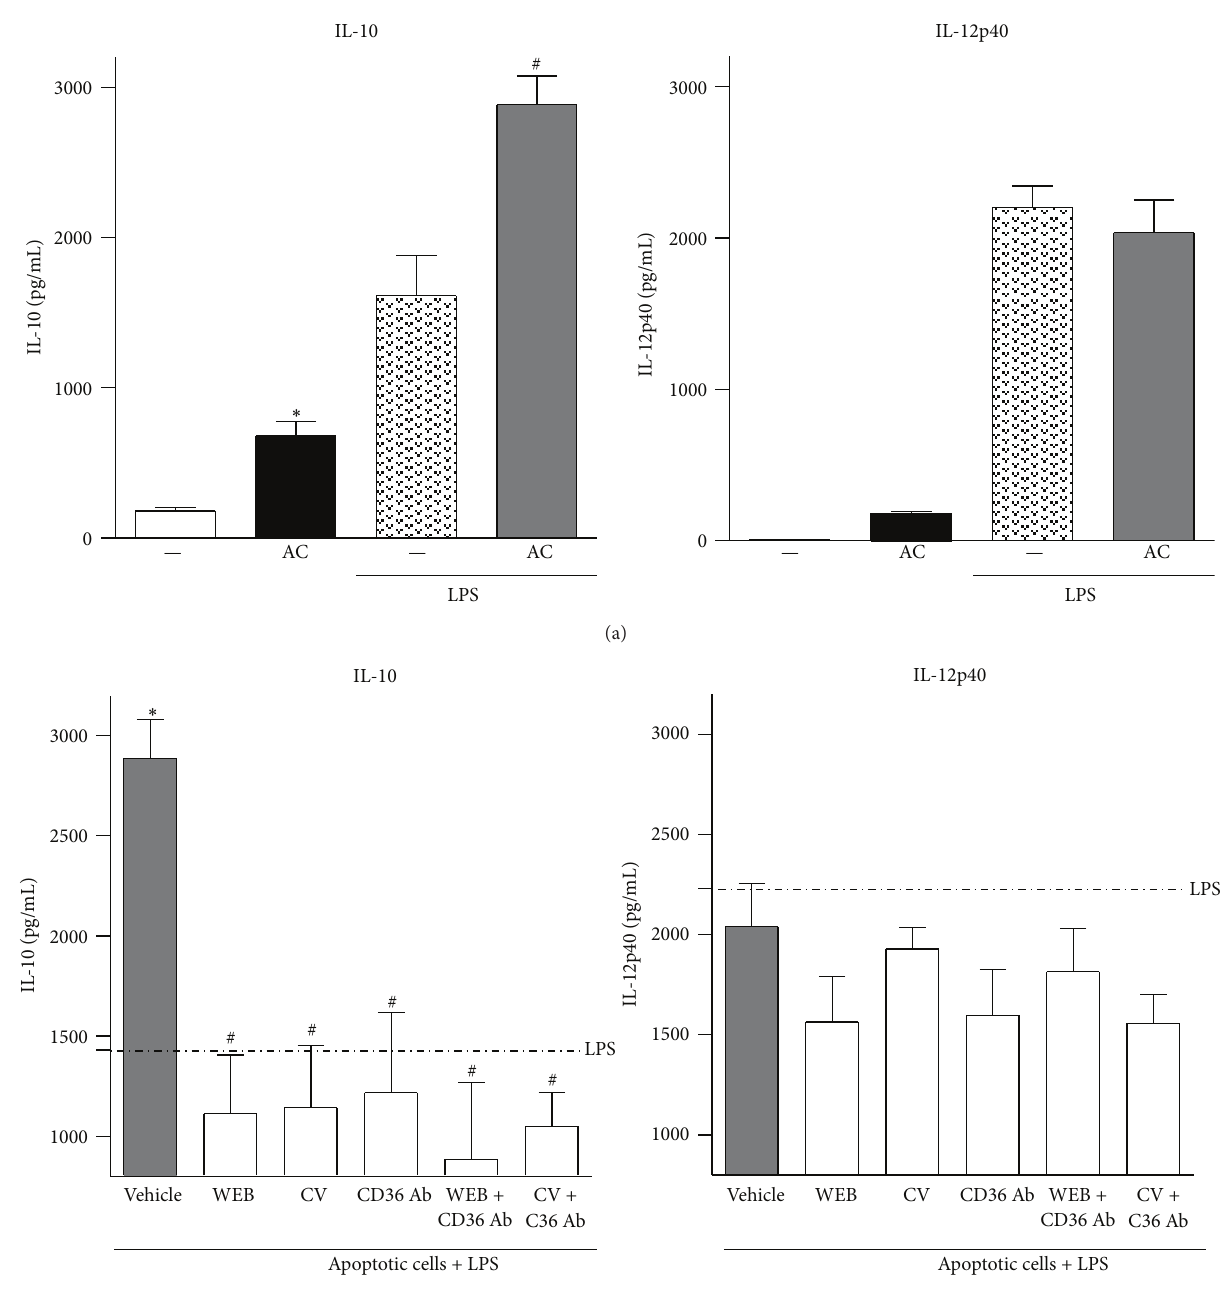
Figure 4: Efferocytosis-induced IL-10 and IL-12p40 production. Apoptotic thymocytes were added to BMDM (10 per macrophage), and after 24 h the supernatants were assayed (a). Another group, after 24h of contact with apoptotic cells, was stimulated with LPS (10ng/mL), and supernatants were assayed after 24. Treatments with PAFR antagonists WEB (WEB2086, 50 𝜇 M) or CV (CV3988, 10 𝜇 M) and with specific blocking antibody to CD36 (1 𝜇 g/mL) were performed 30 min prior to the addition of apoptotic thymocytes. IL-10 and IL-12p40 levels in the cultures supernatants were assessed by ELISA according to manufacturer’s specifications. Data are presented as the mean ± SEM ( ∗ 𝑃 < 0.05 versus control without AC; # 𝑃 < 0.05 versus control with apoptotic